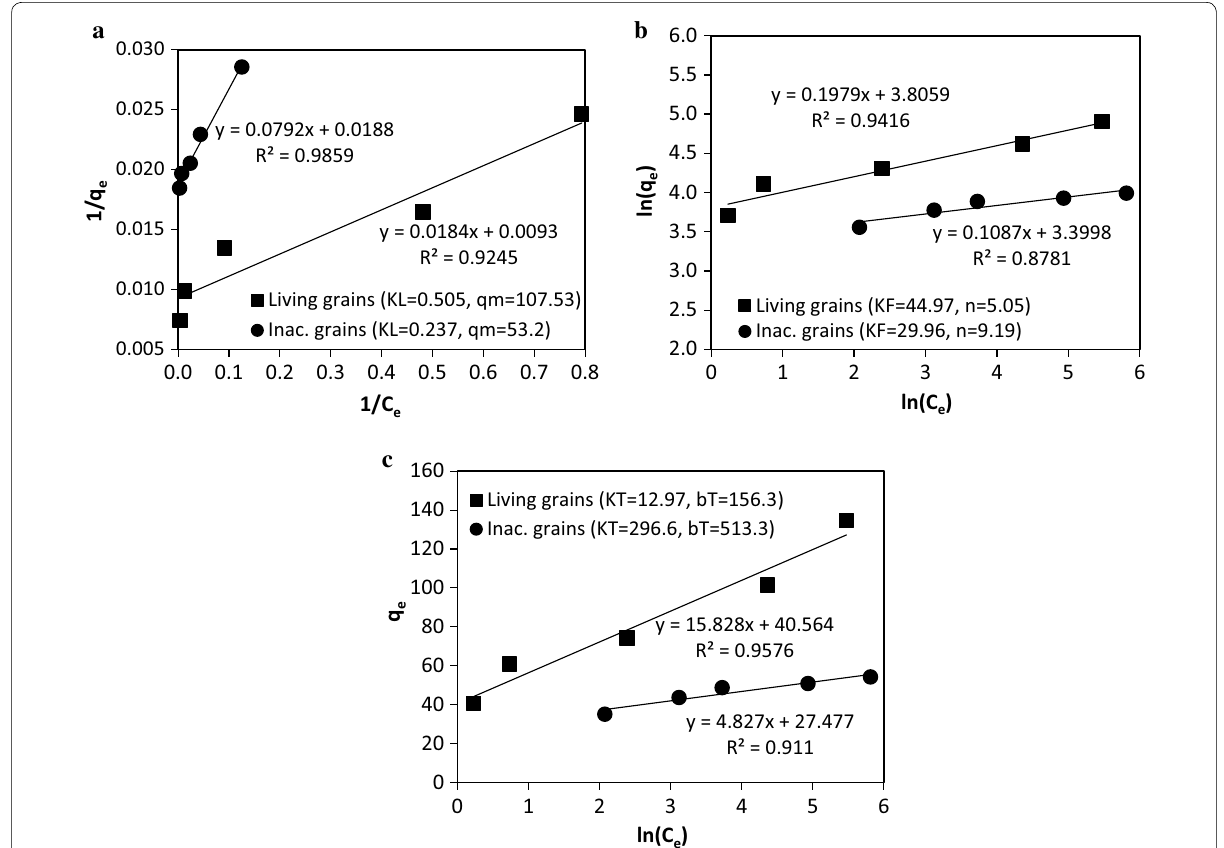
Fig. 3 Linearized form of isotherm models; a Langmuir, b Freundlich, c Temkin